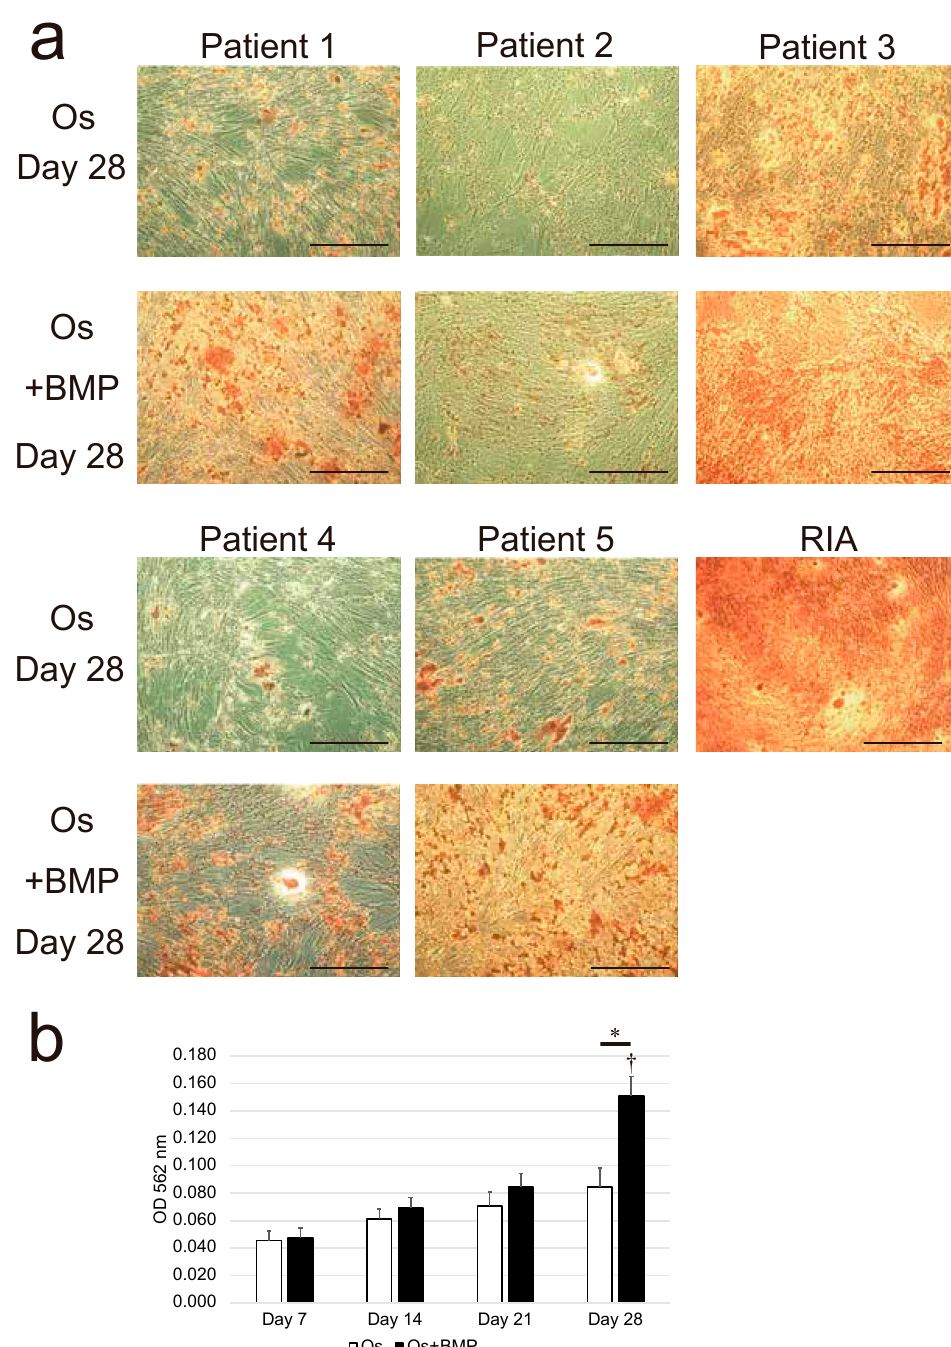
Figure 3. Analysis of the calcification capability of non-hypertrophic nonunion cells (NHNCs). ( a ) Histological analysis of the osteogenic capability of NHNCs and cells derived from a reamer-irrigator-aspirator (RIA, positive control) stained using Alizarin Red S after 28 days of incubation in osteogenic medium (Os) and Os with E-BMP-2 (Os + BMP). In Os, a slightly mineralized matrix was observed as a red-stained nodule. In Os + BMP, mineralization nodule formation was more prominent. Scale bar = 500 µ m. ( b ) Mineralization activity measured as absorbance of NHNCs in Os and Os + BMP at 562 nm on days 7, 14, 21, and 28. * p < 0.05 in the indicated groups and † p < 0.05 compared with day 7 results in Os + BMP group.